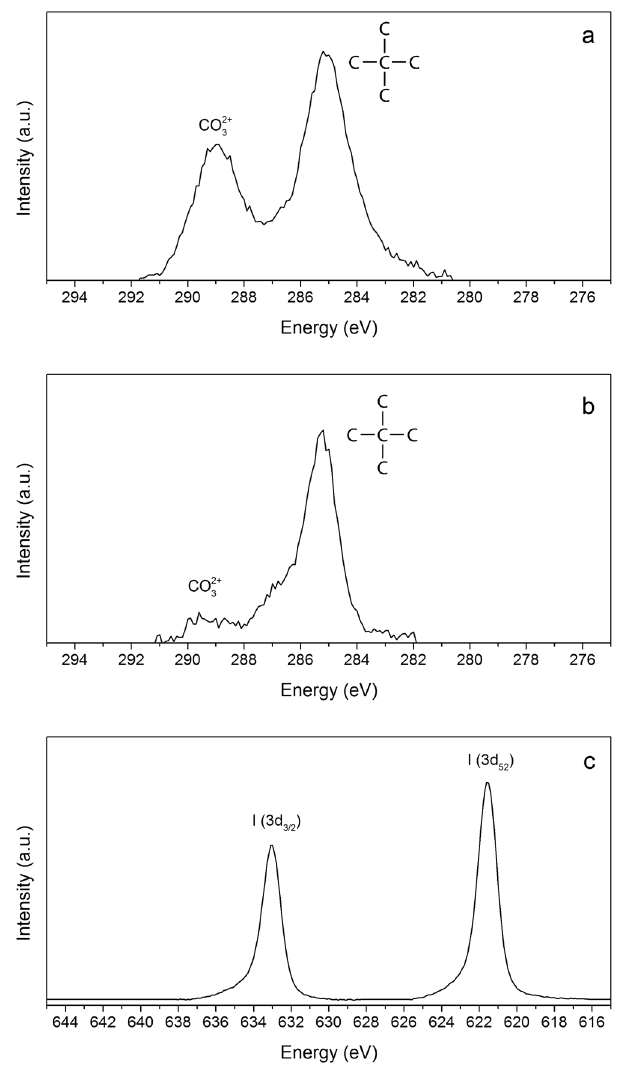
Figure 4. X-Ray Photoemission Spectroscopy for the precursor LDH-CO 3 and the intercalated form LDH-I ( a ) C 1 s peaks for LDH-CO 3 ( b ) C 1 s peaks for LDH-I and ( c ) I 3 d peaks for